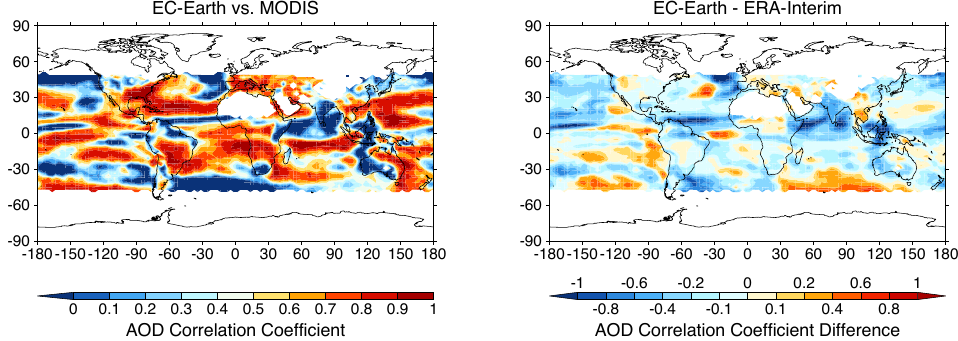
Figure 15. Linear correlation coefficient between the decadal monthly mean aerosol optical depths at 550nm from the reference EC-Earth simulation and the MODIS Level-3 product coarsened to the same resolution (left), and the difference compared to the corresponding correlation coefficient for the ERA-Interim simulation (right). Grid areas where, for all consecutive years, the MODIS data are missing for one or more months are not